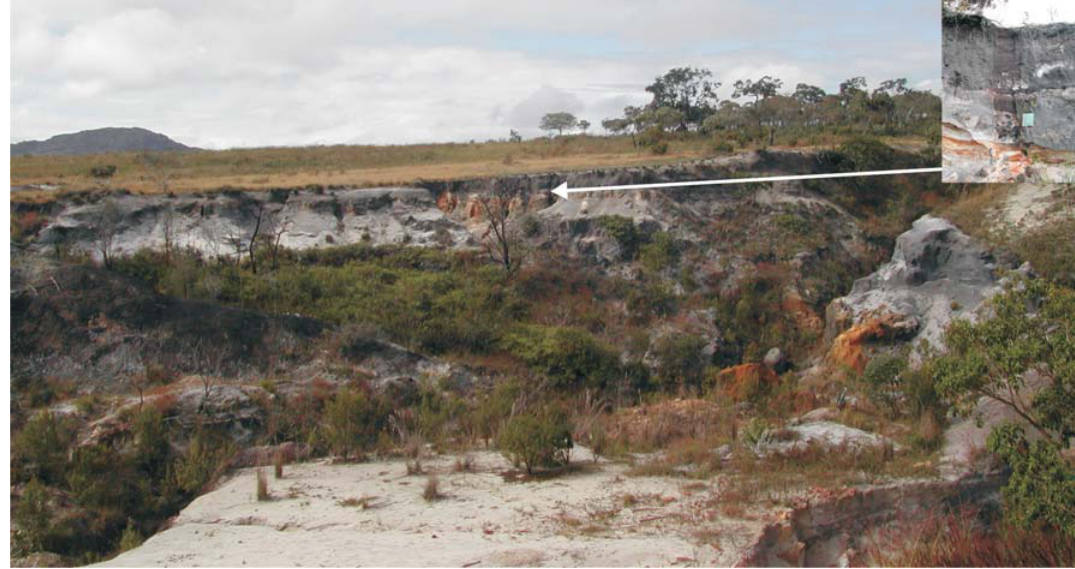
Figura 2. Topo de superfície de aplainamento onde se situa P1 (a); perfil da turfeira P1 (b). Parque Estadual do Biribiri, Diamantina – MG, 18º 08’ 6,9” S e 43º 35’ 6,2”